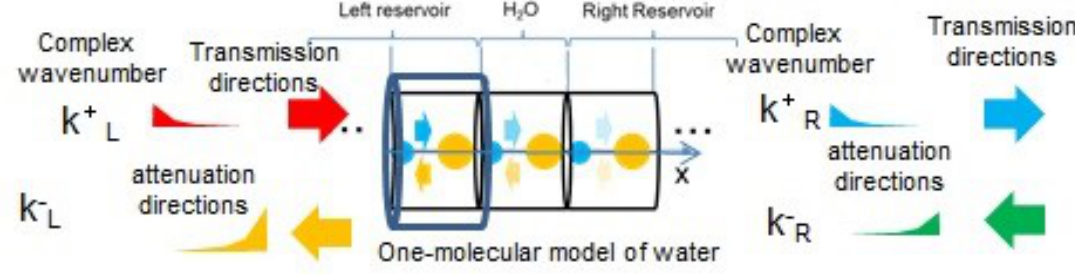
Figure 6. A model of phonon transport through a water molecule between two